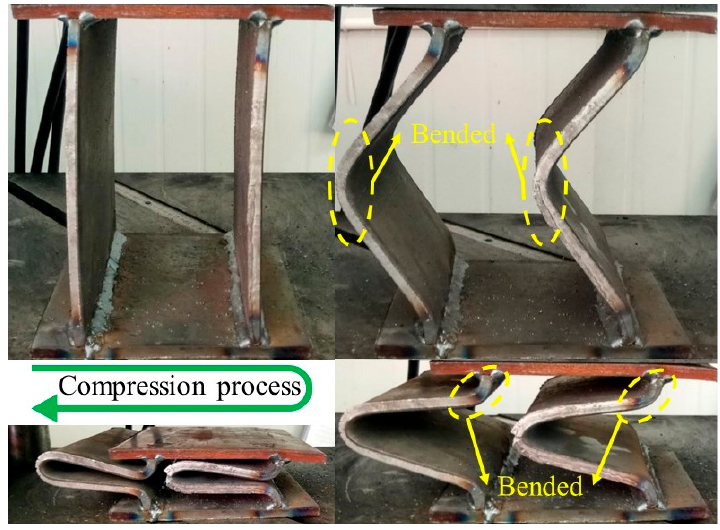
Figure 8. The compression-deformation process of the AED-I.